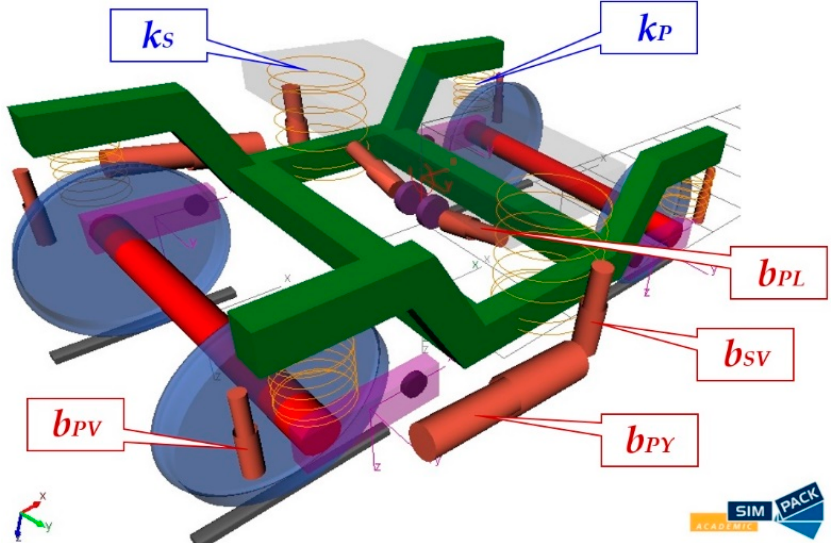
Figure 7. An illustration of the created multibody model of the bogie with designated individual suspensions components.